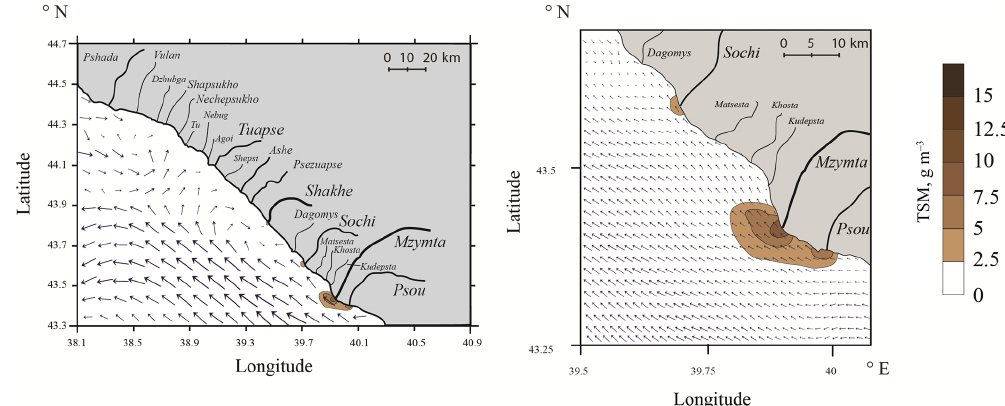
Figure 12. Modeled surface TSM distribution at RCBS (left) and its southern part (right) under the averaged mode on 1 July 2011.